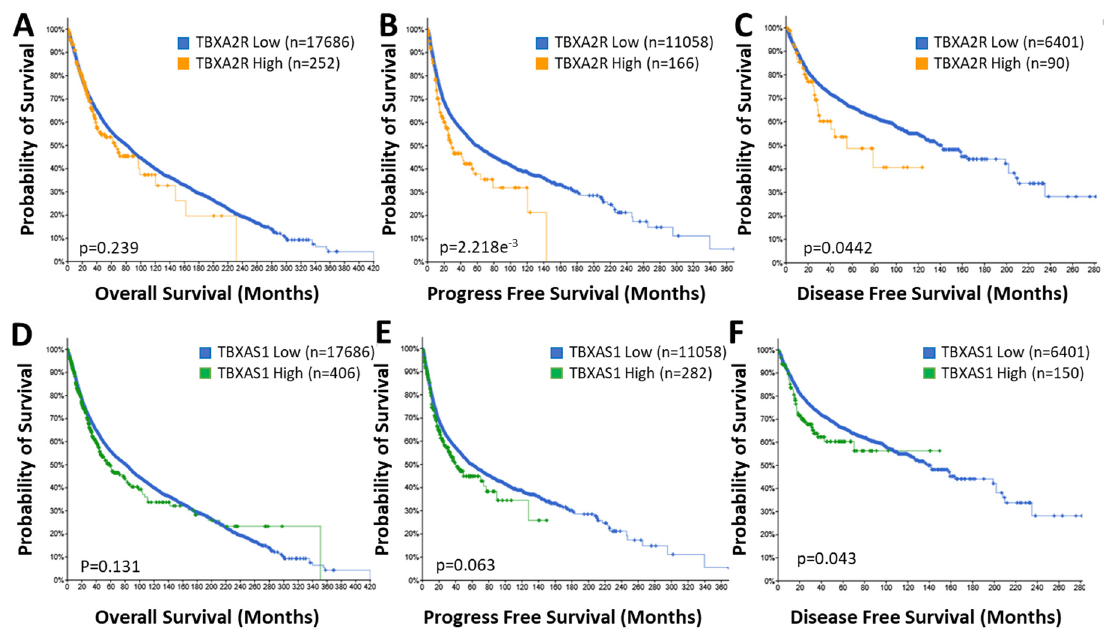
Figure 3. Elevated TBXA2R and TBXAS1 Expression Is Associated with Poor Prognosis. Data from the TCGA pan-cancer database for TBXA2R ( A – C ) and TBXAS1 ( D – F ) was correlated with overall ( A , D ), progression free ( B , E ) and disease free ( C , F ) survival in patient populations with low ( ♦ ) and high ( ♦ , TBXA2R ; ♦ , TBXAS1 ) expression. n = number of patients in the cohort.